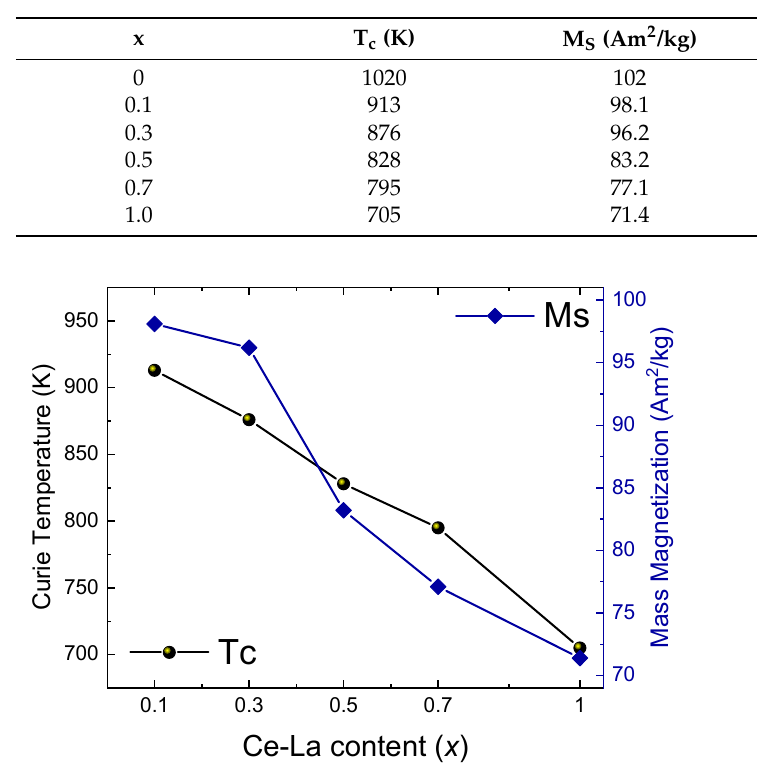
Figure 5. Dependence of magnetic properties with Ce,La content in Sm 1 − x (Ce 0.75 La 0.25 ) x Co 5 (x = 0.1–1.0) samples.